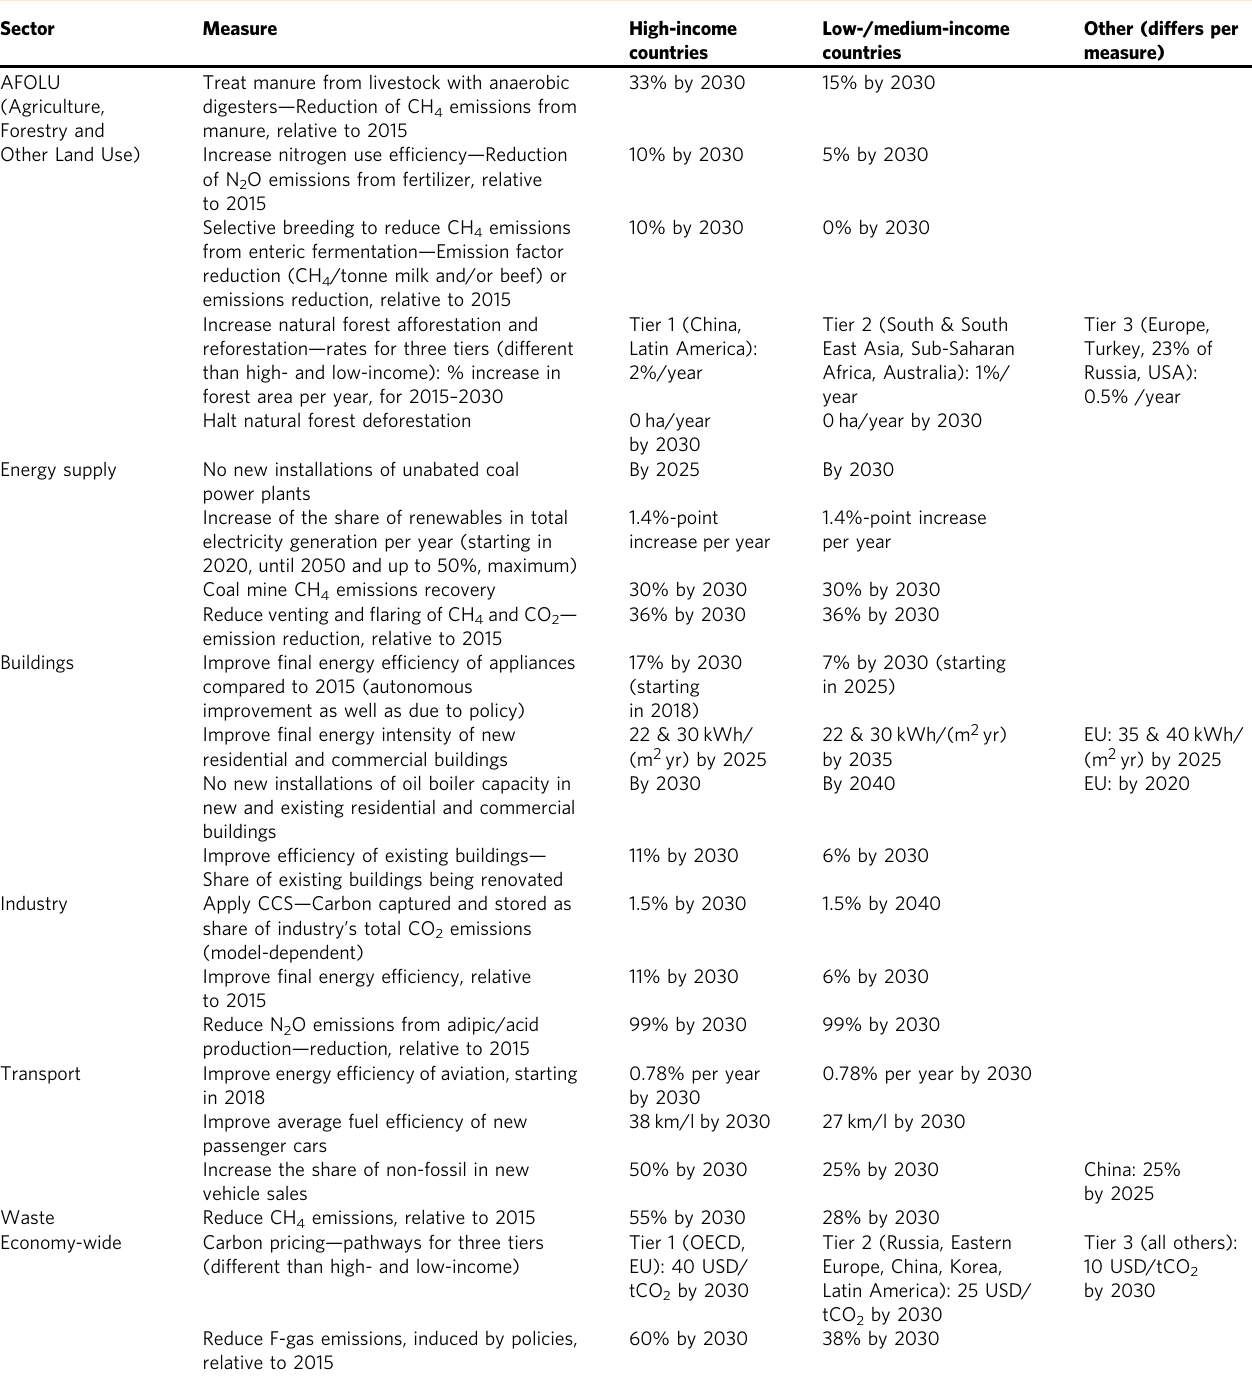
Table 1 The good practice policies that were assumed to be replicated globally in the Bridge scenario, with differentiated targets for high-income and low-/medium-income countries, adapted from earlier analysis of good practice policies 7 – 9 .